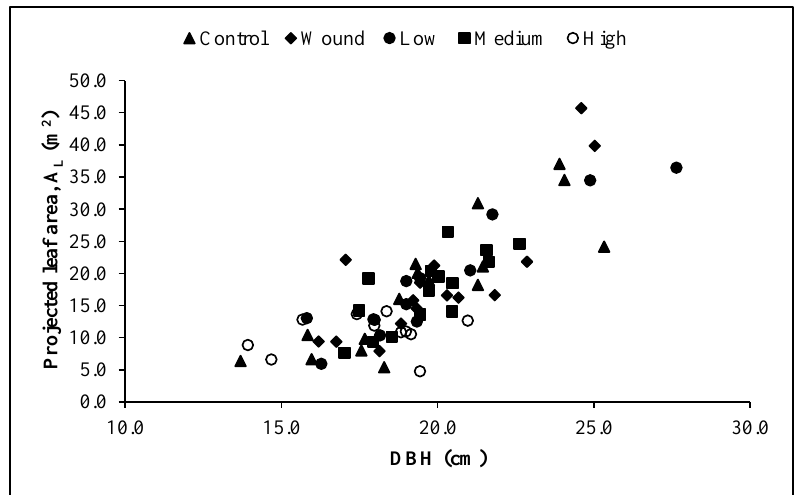
Figure 4. Relationship between diameter at breast height (DBH) and projected tree leaf area of P. taeda 34 months following lower stem inoculation with L. terebrantis -colonized toothpicks. Significant linear relationships were observed among the 15 trees receiving the control ( p = 0.0005, r 2 = 0.84), wound ( p = 0.0013, r 2 =0.67), low ( p = 0.0001, r 2 = 0.87), or medium ( p =0.0011, r 2 = 0.57) inoculation